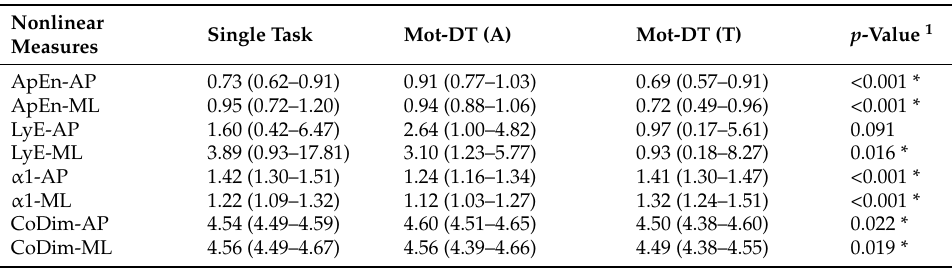
Table 2. Comparisons of CoP time series displacements among postural single task and easy and difficult motor dual tasks, median